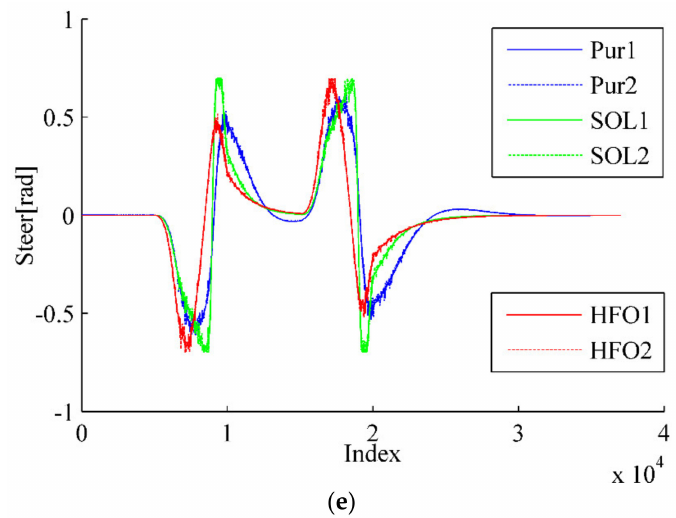
Figure 10. Double lane-changing test scenario. ( a ) Trajectory tracking (3D), ( b ) Trajectory tracking (2D), ( c ) Lateral error, ( d ) Heading angle, ( e ) Steer